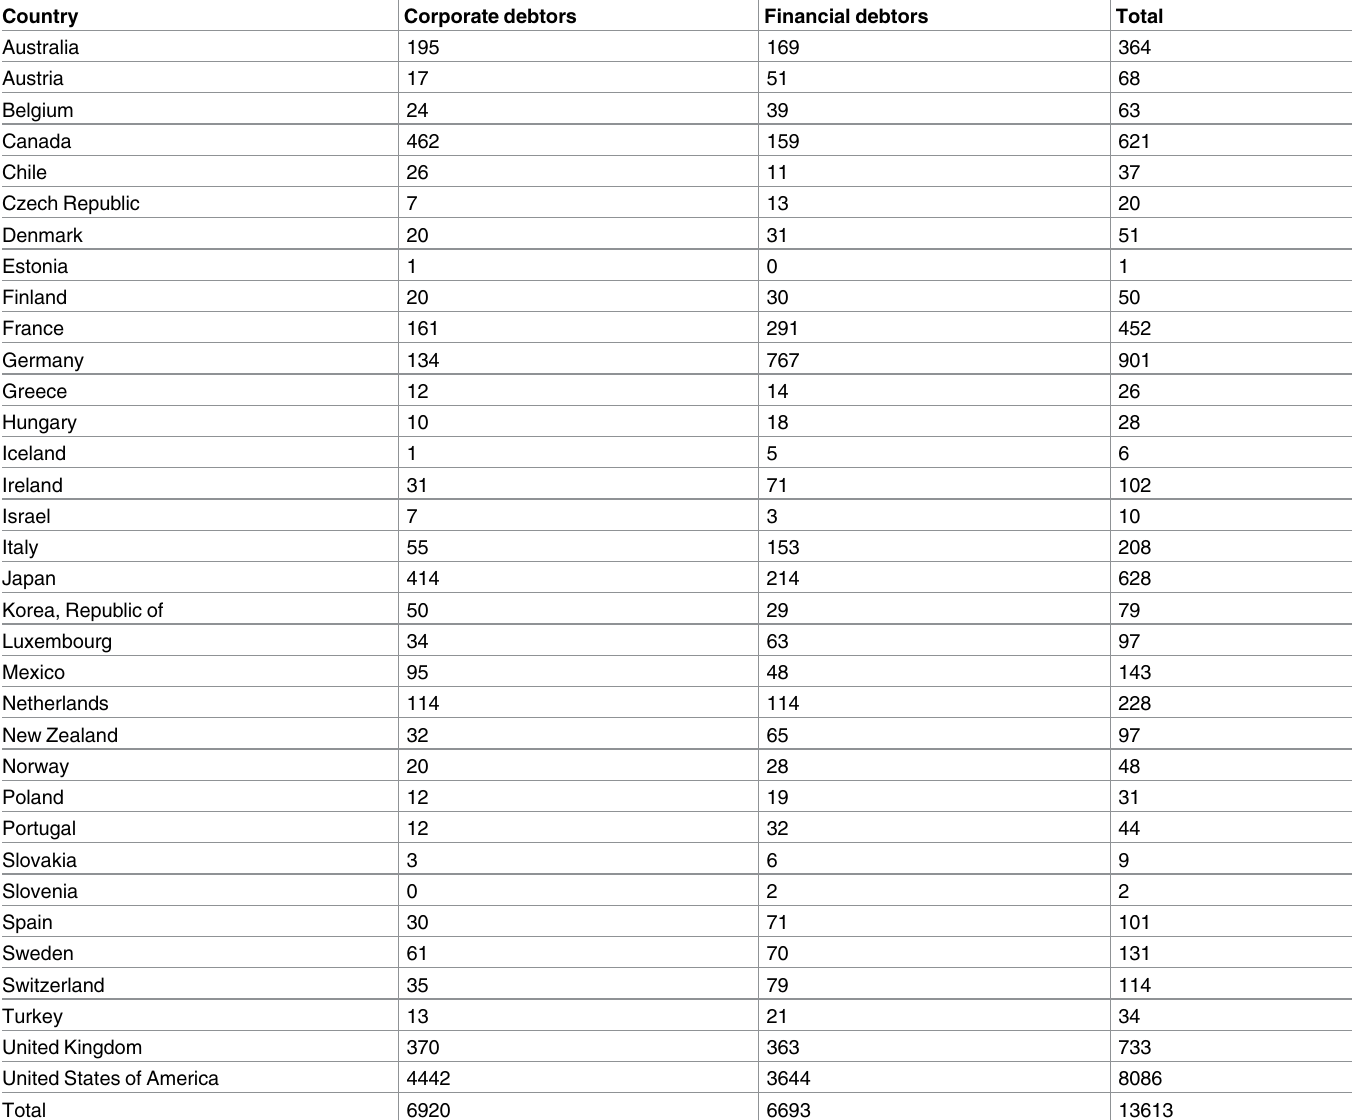
Table 3. OECD countries covered by dataset.